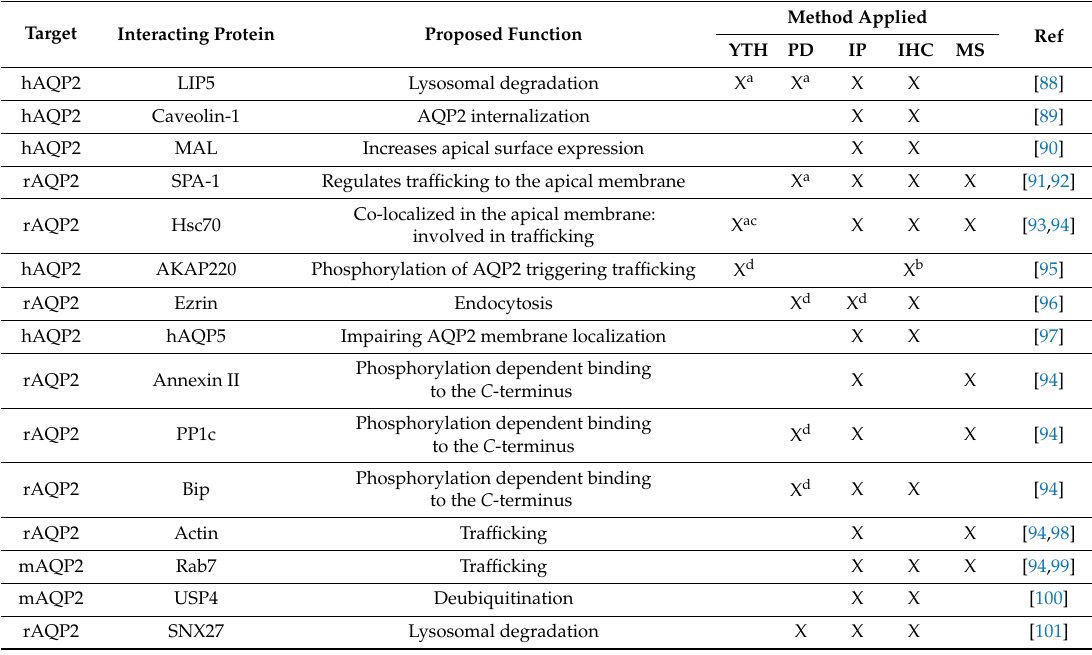
Figure 2. AQP2-interacting proteins. AQP2 binding partners are indicated, as well as the location for the interaction in those cases where it has been mapped (Table 2). Table 2. AQP2-interacting proteins.